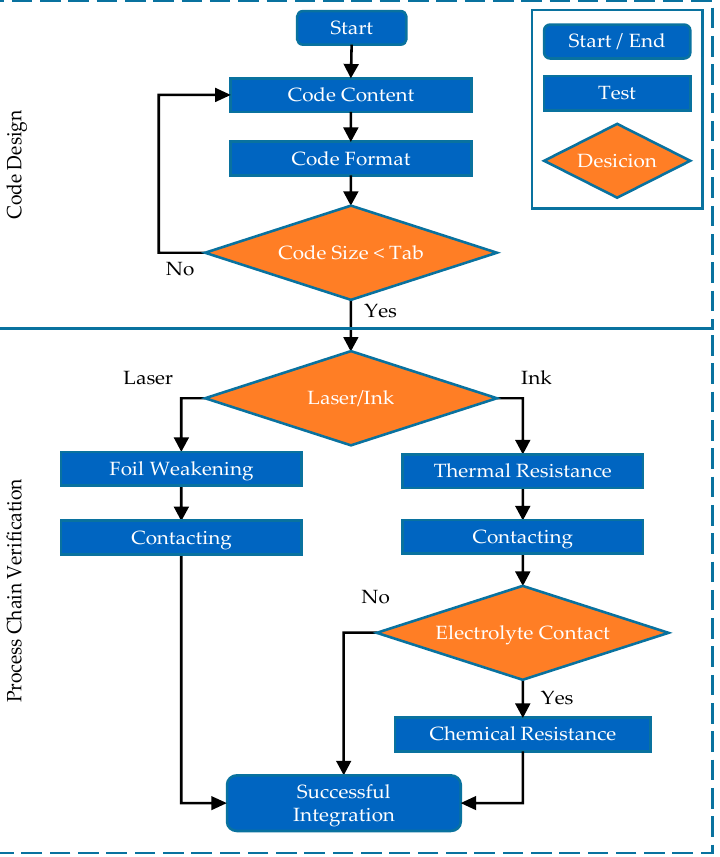
Figure 2. Flow diagram showing the necessary investigations for the successful integration of marking; the diagram is divided into code design and process chain verification, as well as laser and ink technology paths.